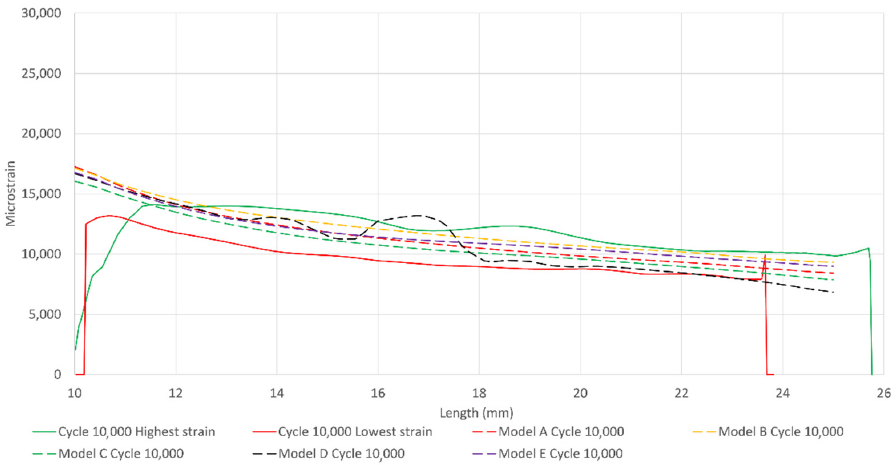
Figure 22. Lowest and highest hoop strain at 10,000 cycles from Figure 18 compared to the analy- sis results.